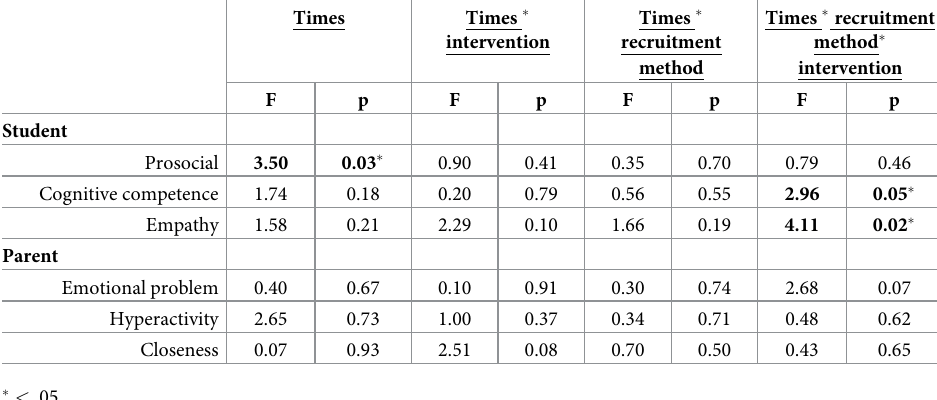
Table 4. Results of mixed ANOVA of the Caring Kids and recruitment method on outcome variables at different time